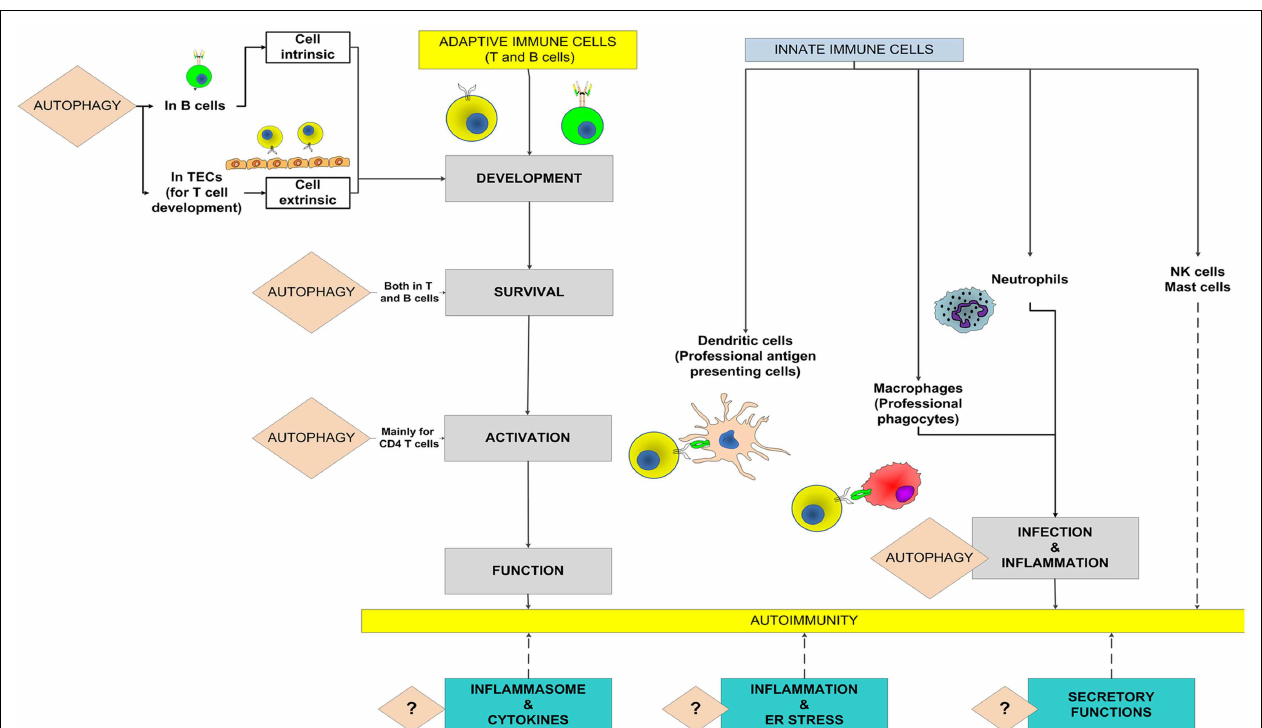
potential contributions toward autoimmunity. A question mark denotes the possibility that the autophagy pathway might modulate autoimmune diseases through these processes.TECs, thymic epithelial